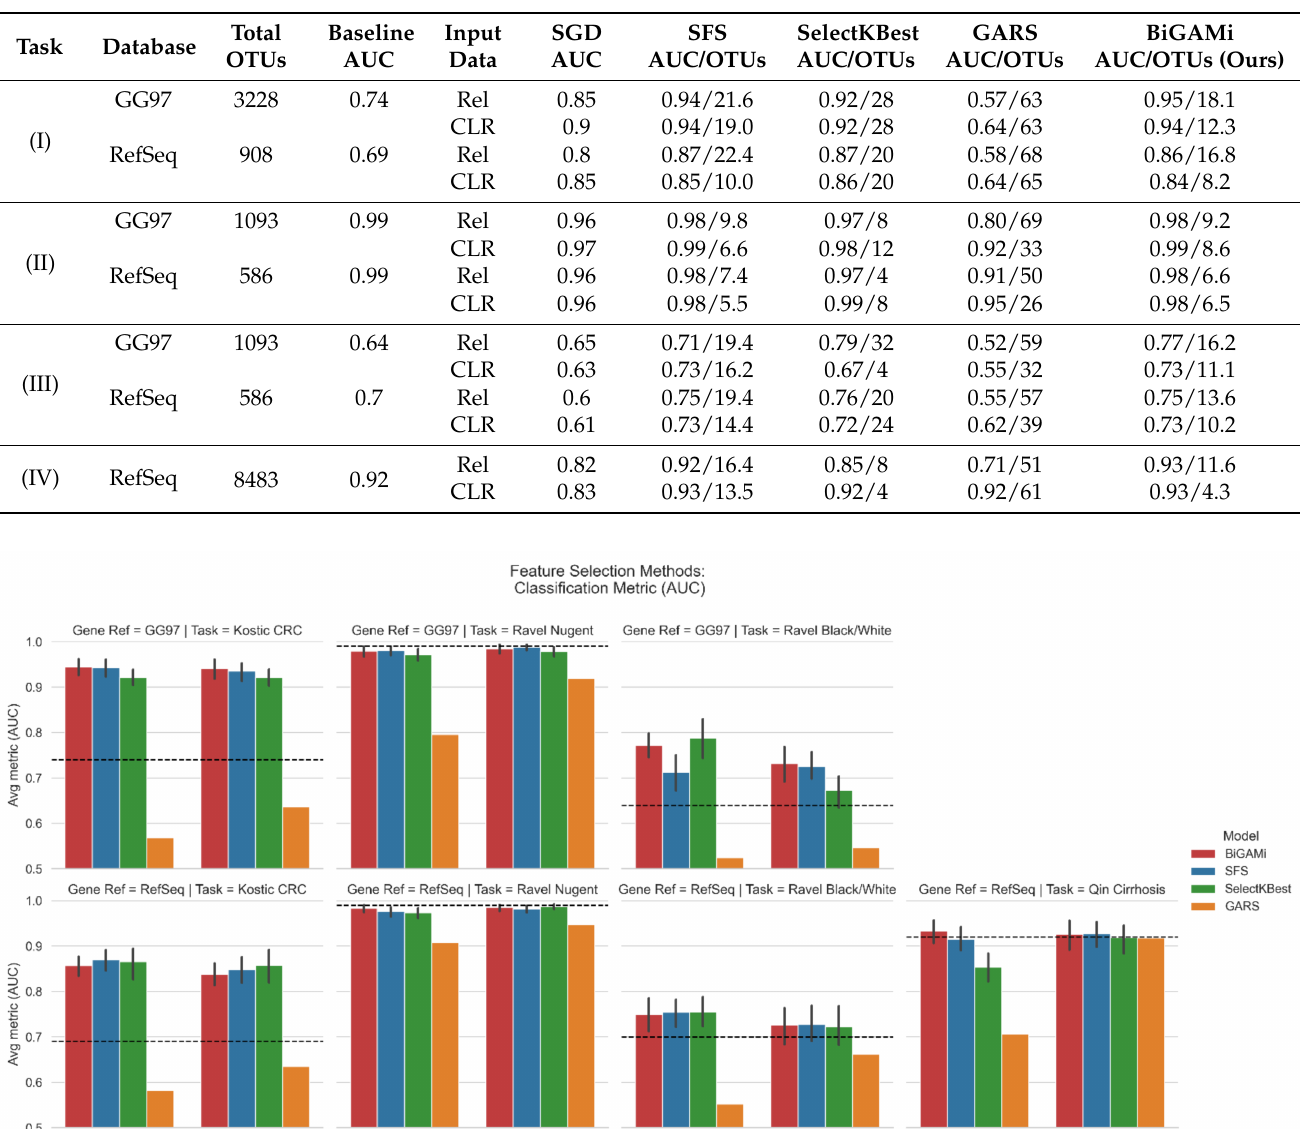
Table 3. Performance results per classification task. Per input data, the average AUC score and the average number of OTUs are provided. (I) Kostic colorectal cancer healthy/tumor GG97, (II) Ravel vaginal Nugent category, (III) Ravel vaginal black/white, (IV) Qin cirrhosis RefSeq. Rows with an * symbol were selected for taxonomy analysis of selected feature subsets.